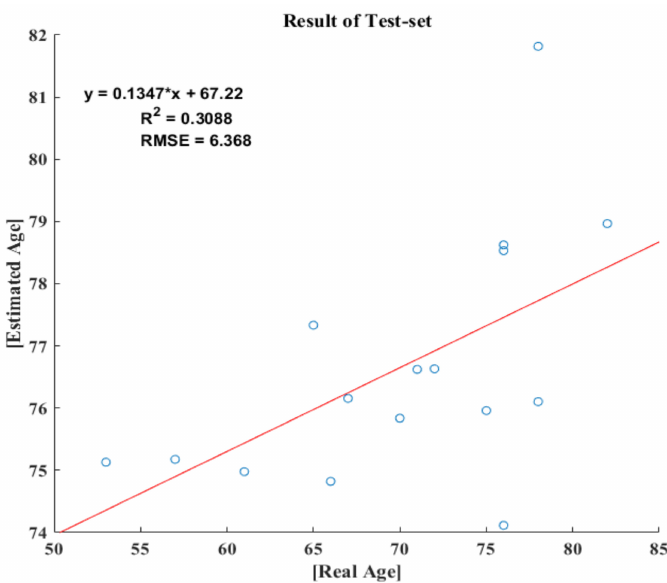
Figure 5. Results of predicted age by